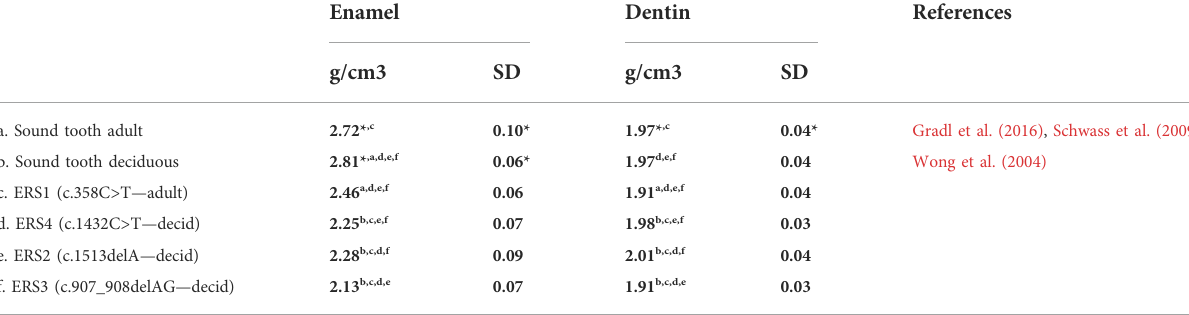
TABLE 1 HAP density of enamel and dentin for each sample, ERS and sound teeth. SD, standard